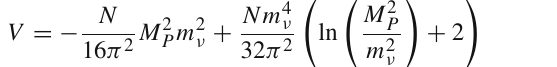
cedure known as the “block-spin renormalization group”